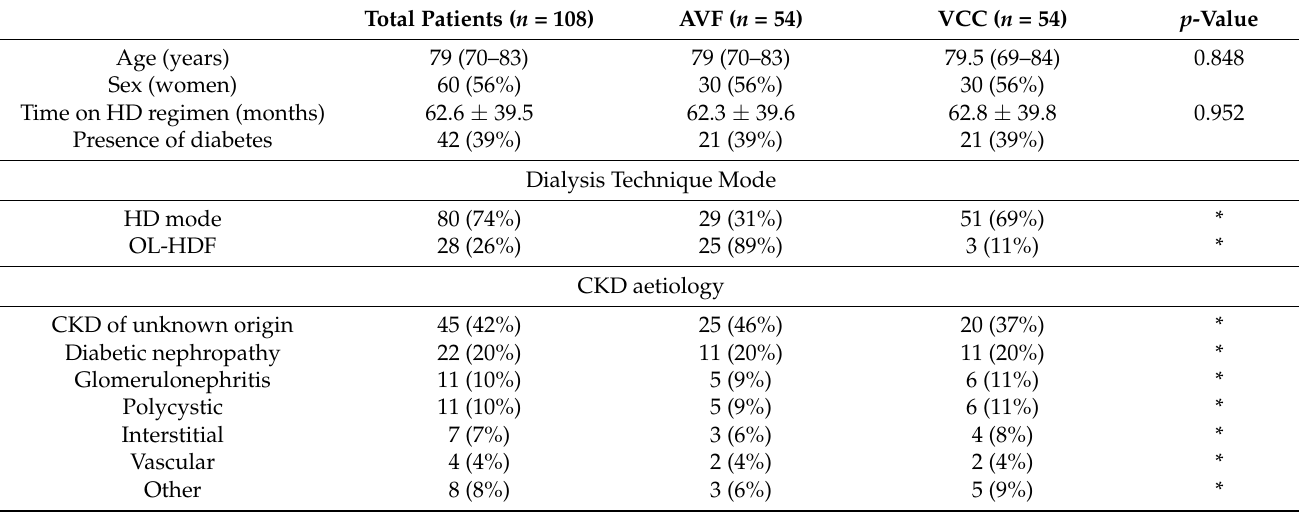
Table 1. Baseline values for the paired variables and the base aetiologies of the total number of patients and of both groups of